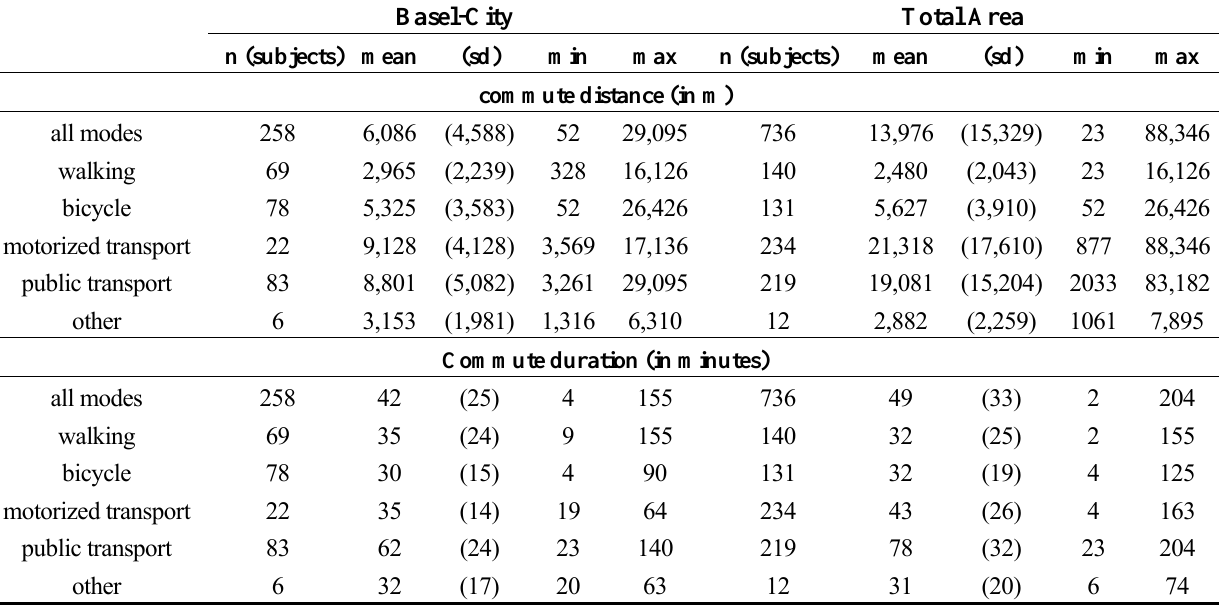
Table 2. Daily commuter distance and commuter duration of subjects per main travel mode and study